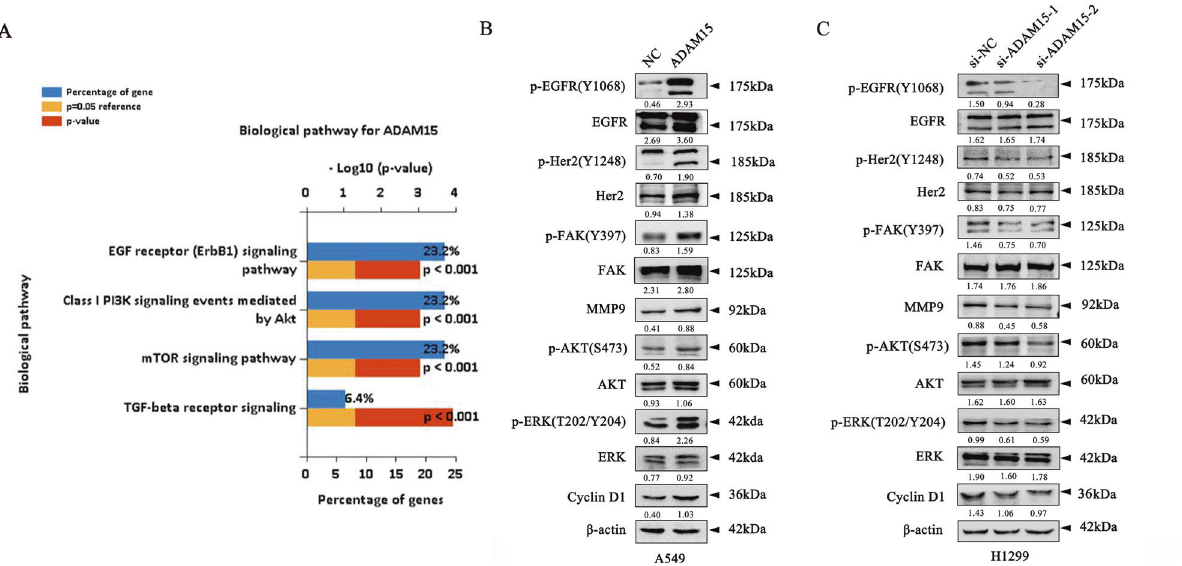
Fig. 3 ADAM15 affects the EGFR-FAK signalling pathways in ADAM15-overexpressing A549 cell lines and ADAM15-knockdown H1299 cell lines. A Data from TCGA database and analysed by FunRich software (version 3.1.3). B , C Various protein mRNA and protein expression levels were measured by western blot analysis in ADAM15-overexpressing A549 cell lines and ADAM15-knockdown H1299 cell lines. β -actin was used as a loading control. * P < 0.05; ** P < 0.01; *** P <